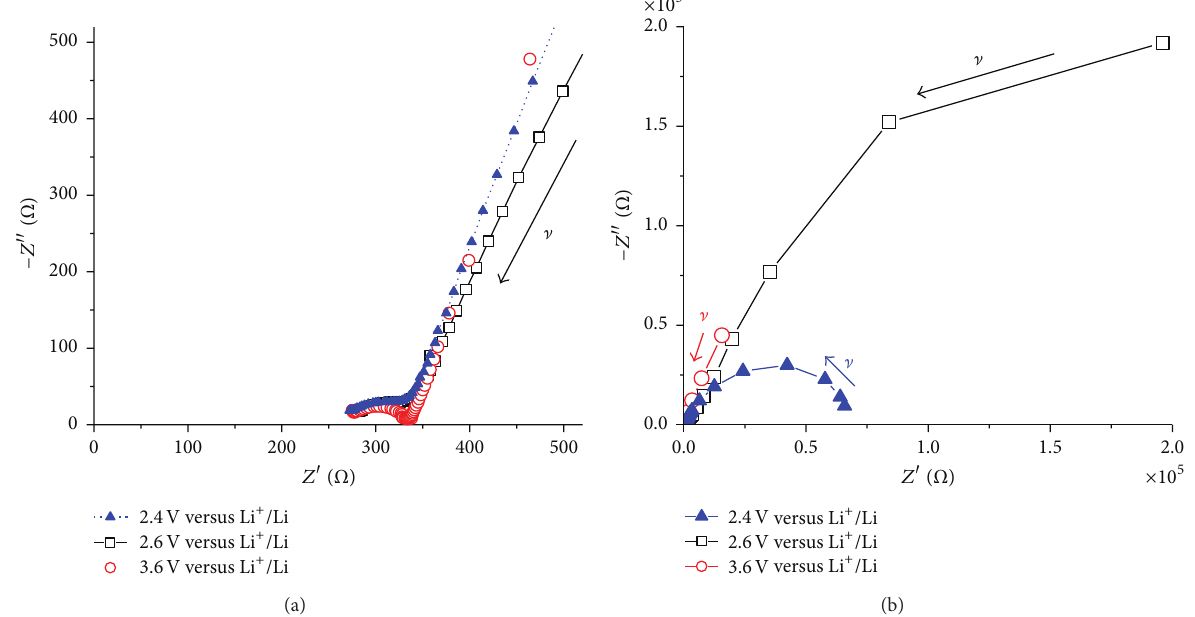
Figure 26: Electrochemical impedance spectra of ERY-sensitized CS NiO have been recorded in dark conditions and displayed as Nyquist plots ((a) small scale; (b) large scale). NiO film thickness: 0.3 𝜇 m; substrate: ITO. Arrows indicate the direction of increase for the frequency of